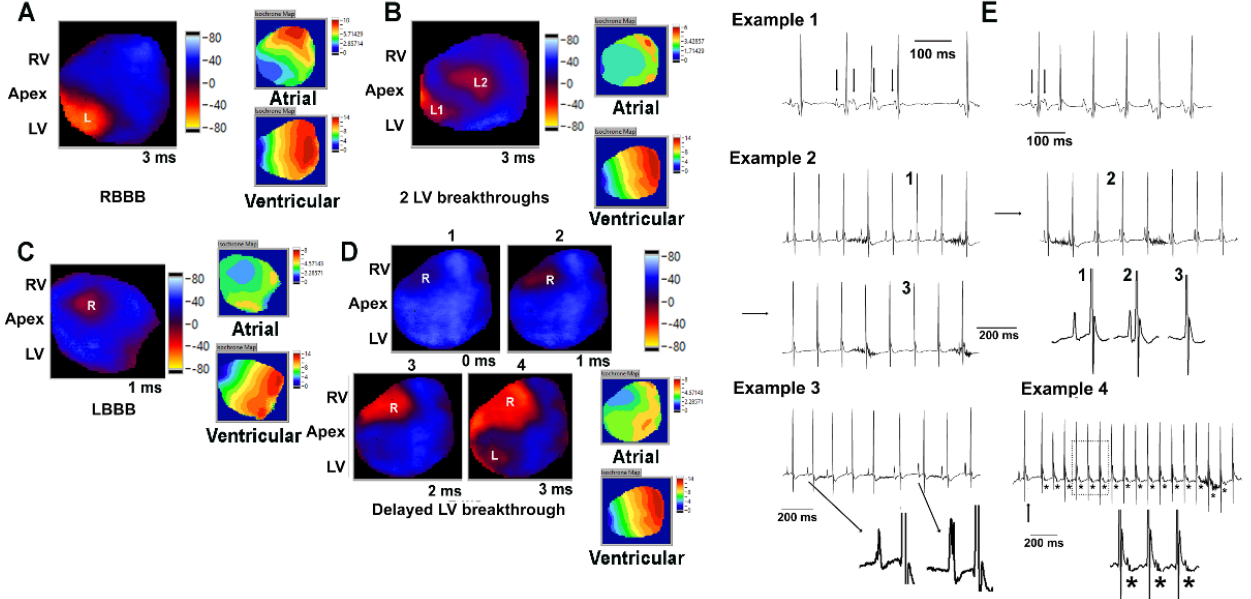
Figure 4. Loss of Hand2 in embryonic CCS results in ventricular conduction defects and atrial arrhythmias. Snapshots of representative epicardial voltage maps obtained during right atrial pacing (cycle length, 120 ms) in isolated-perfused H2LVCreCKO or H2control hearts. Isochrone activation maps during atrial and ventricular pacing (cycle lengths, 120 ms) are also shown for each heart. Number below each snapshot image is time in ms with 0 being the time of first epicardial breakthrough. Color codes for snapshots are in arbitrary units. Please note that membrane depolarization causes a decrease in the dye’s fluorescence intensity. Color codes for the activation maps are in ms. R, right; L, left. ( A ) Right BBB, only left side epicardial breakthrough (L). ( B ) Two LV breakthrough sites (L1, L2). ( C ) LBBB, only right side epicardial breakthrough (R). ( D ) Several millisecond delay between RV and LV activation. ( E ) Examples of spontaneous arrhythmias in H2LVCreCKO mice. Example 1, left panel: short run of atrial tachycardia with Wenckebach-type AV conduction block (left; first arrow denotes sinus beat whereas the following three arrows indicate atrial premature beats exhibiting a P wave morphology that is distinctly different from that during sinus rhythm. The third premature beat is not conducted to the ventricles). Right: A sinus beat (first arrow) is followed by an atrial premature beat (second arrow) initiating a sustained atrial tachycardia. Note difference in P wave morphology before from that during tachycardia. Example 2: progressive shortening of PR interval until the P wave is eventually embedded in the QRS complex and undetectable on the ECG. The sinus node functions as a pacemaker for the atria but slowed conduction across the AV node allows a junctional pacemaker located between the AV node and the origin of the His bundle branches to emerge and drive the associated QRS complex, i.e., junctional rhythm. Left lower panel shows zoom-in views of the correspondingly numbered cycles in the low-resolution traces. Example 3: sudden change in P wave morphology, indicative of a competing ectopic atrial pacemaker. Example 4: sustained supraventricular tachycardia with 1:1 AV conduction. Asterisks (*) denote P waves. The tachycardia is initiated by an atrial premature contraction (arrow). Lower trace shows zoom-in views of 3 consecutive cycles framed by the dotted